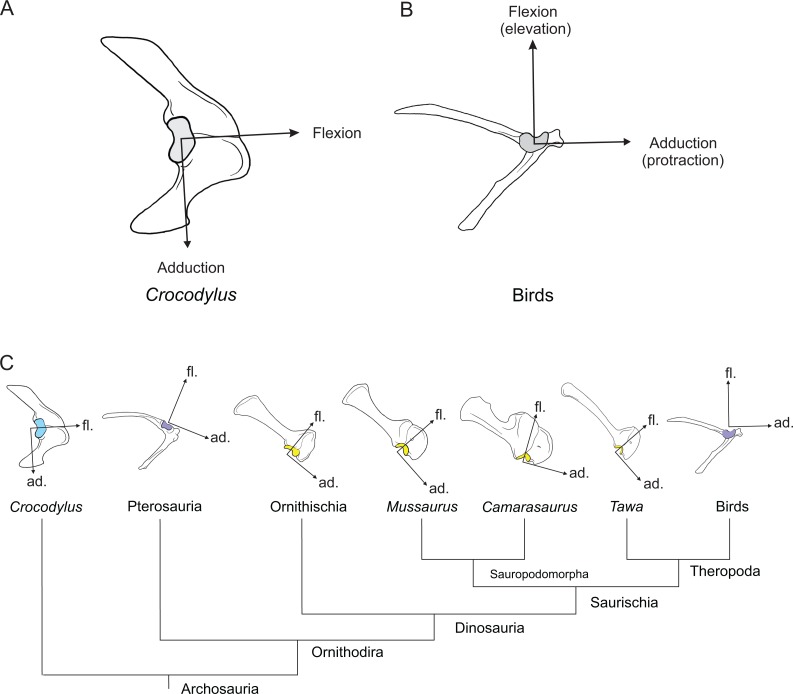
Terminology for homologous joint movements as the glenohumeral articular surface transformed across Archosauria.(A) Crocodylus and (B) a generalized bird showing homologous joint movement (in this case perpendicular to the long axis of the glenoid) along the extremes of locomotor patterns within Archosauria. (C) Evolution of muscle action around the flexion/extension axis along the ornithodiran line from the ancestral archosaurian pattern for a homologous movement. Same colour/tone indicates the same glenohumeral joint orientation. Line drawings modified from: Crocodylus and generalized bird (Gatesy & Baier, 2005); Pterosauria (Witton, 2015); Ornithischia (Maidment & Barrett, 2011); Camarasaurus (Wilson & Sereno, 1998) and Tawa (Burch, 2014). ad., adduction; fl., flexion.